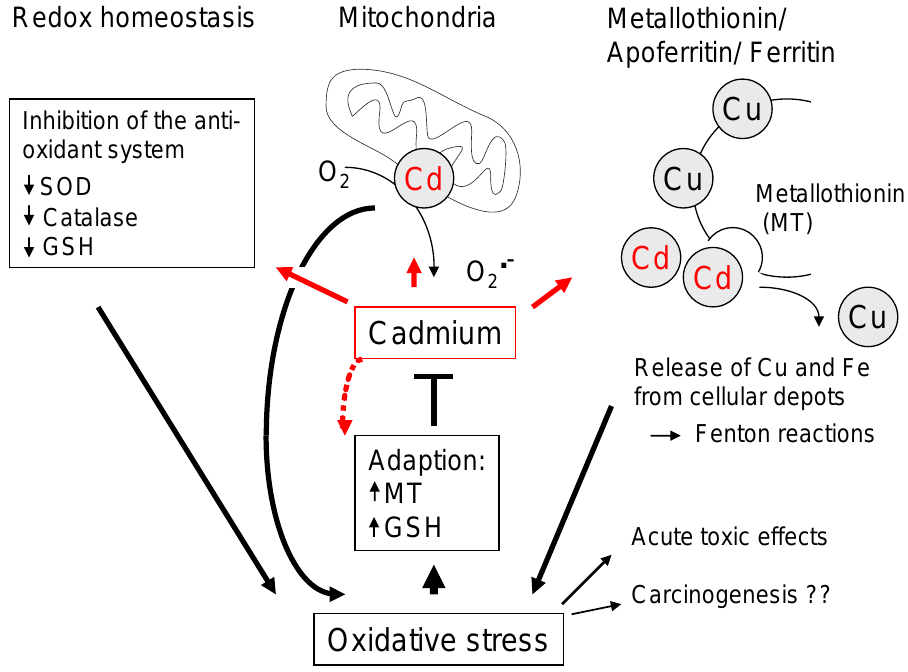
Figure 4. Cadmium and oxidative stress. Cadmium does not belong to redox-active